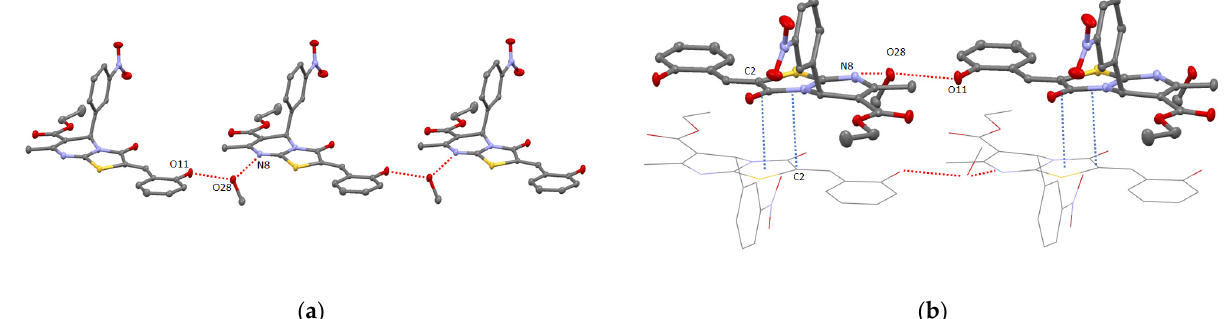
Figure 6. ORTEP view of supramolecular 1D chains resulting from intermolecular H ‐ bonding in the crystals of compound 10 ‐ MeOH ( a ) and π‐ staking involving the thiazolyl groups ( b ). The ellipsoids are presented with 50% probability, H ‐ atoms are omitted for clarity. H ‐ bonding and π‐ stacking are presented by red and blue dotted lines, respectively.